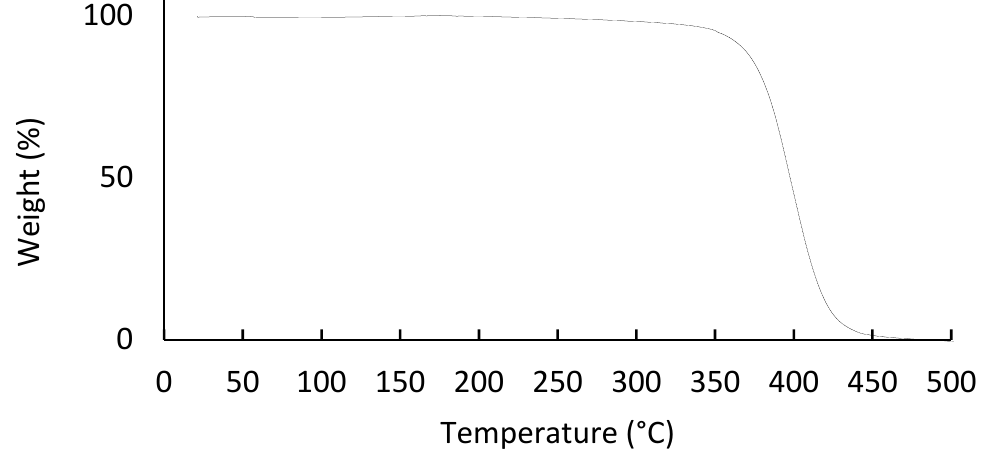
Figure 4. Thermogravimetric analysis curves of electrospun PA nanofibres.